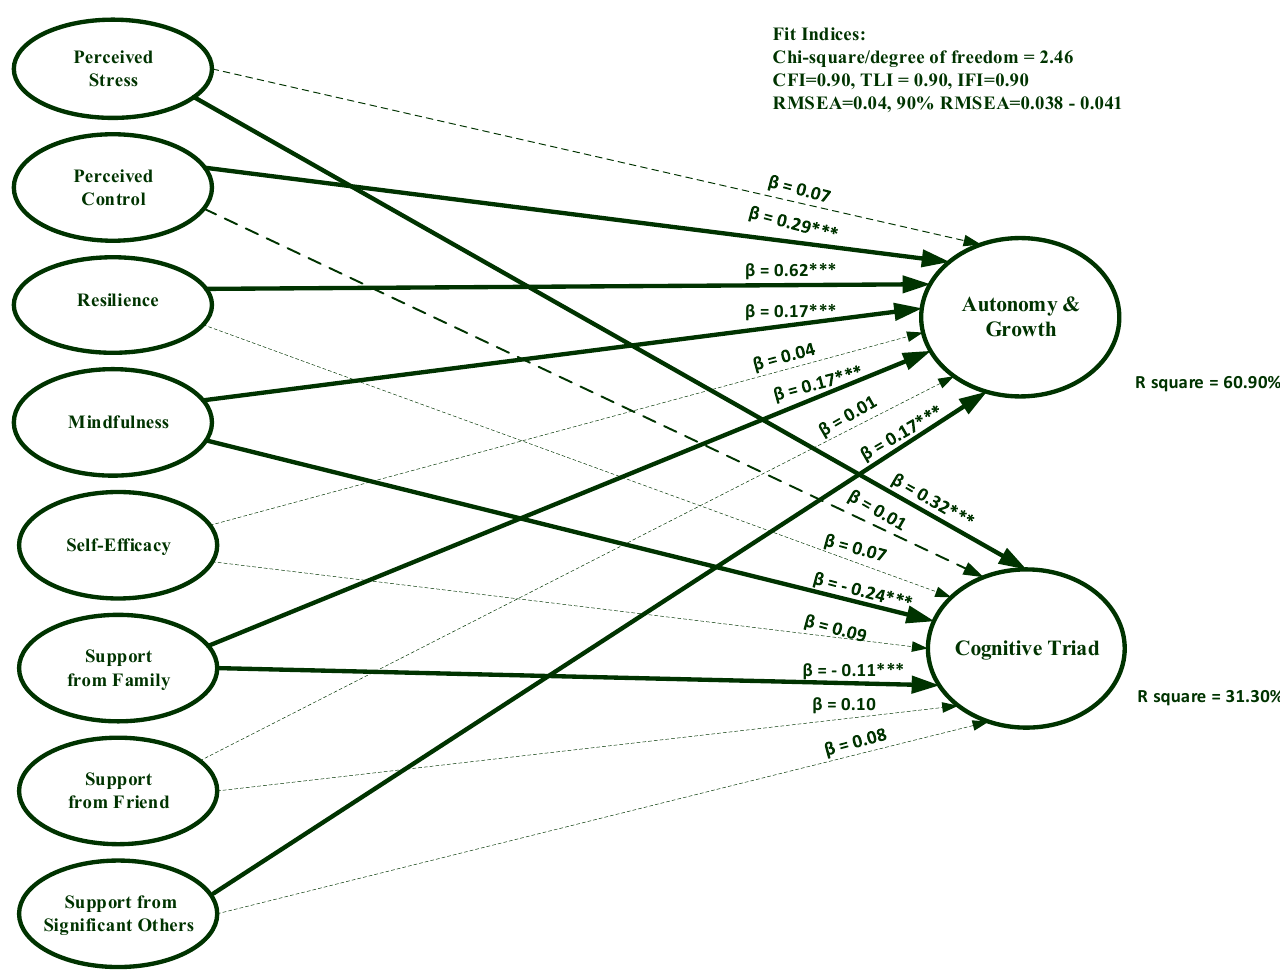
Figure 1. Predictors of psychological well-being among university students in Thailand. *** Signif- icant at 0.001.